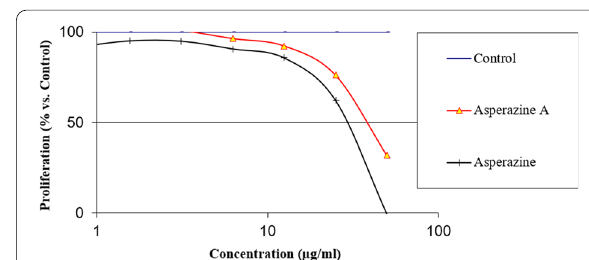
Fig. 4 Antiproliferative effects of asperazine (1) and asperazine A (2) on HUVEC